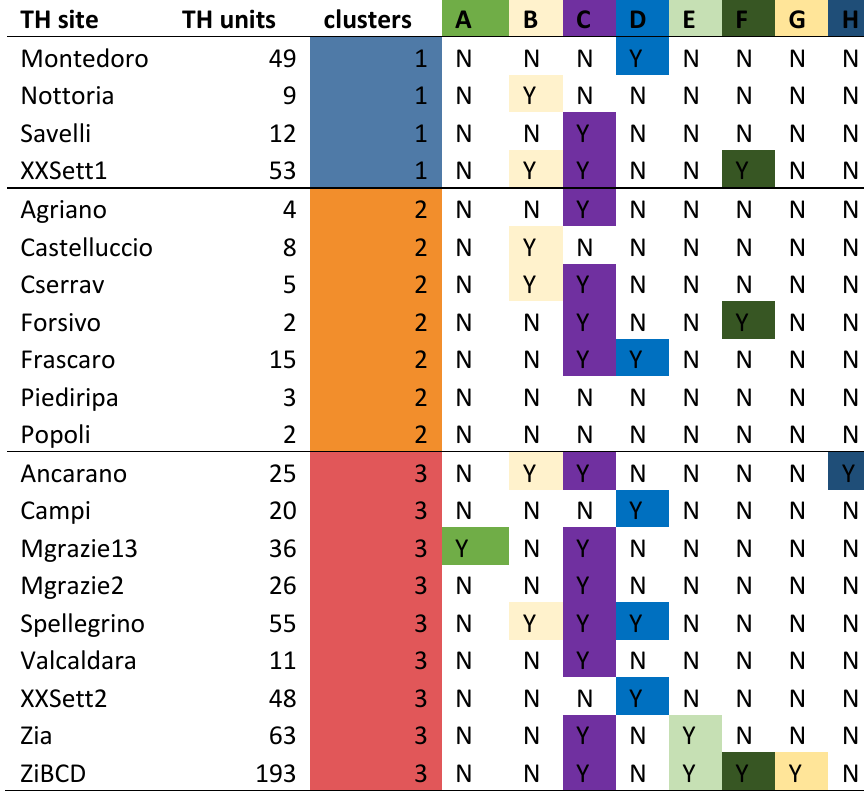
Table 2 Future uses of Norcia TH sites, PRG